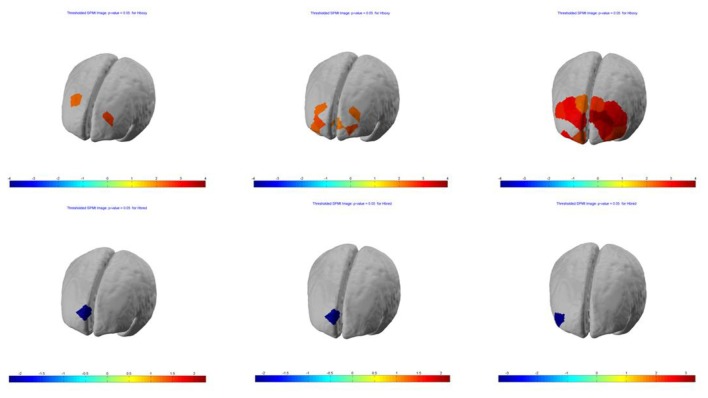
Session 3—group (n = 13) Statistical Parametric Mapping (SPM) activation t-maps of oxygenated (HbO; top) and deoxygenated (HbR; bottom) pit room > training room, threshold level p < 0.05 for each of three blocks 1-early, 2-mid and 3-late, respectively. The color bar represents t-values.